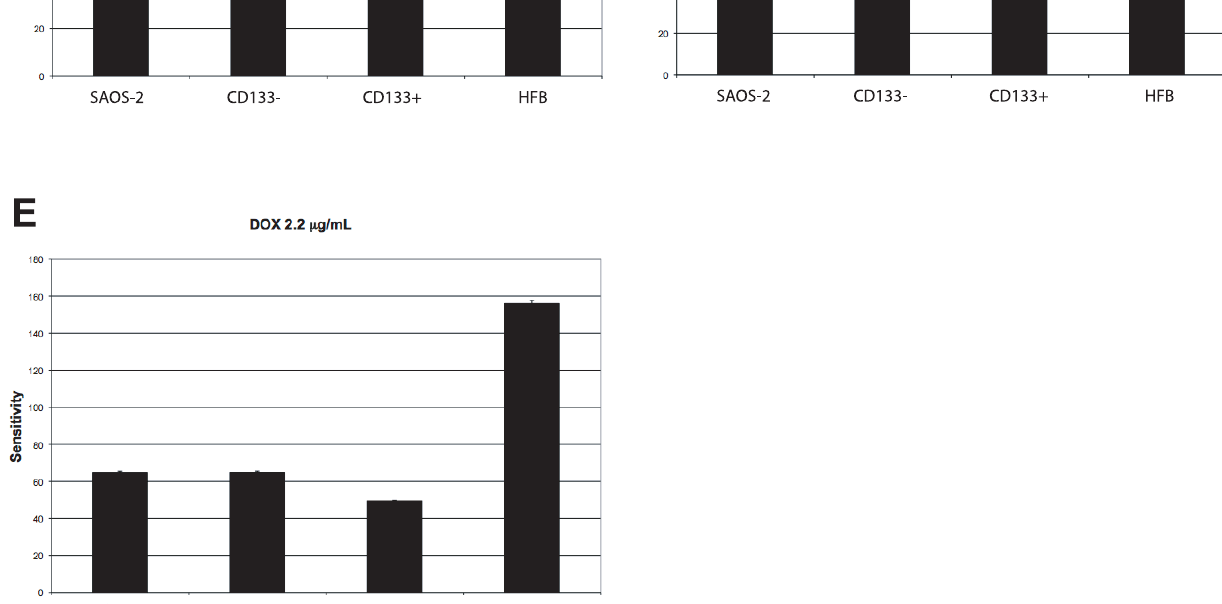
Figure 9. Sensitivity of SAOS-2 cells to doxorubicin following growth in simulated hypogravity. A ) LD 50 for doxorubicin determined for the SAOS-2 cells. An LD 50 of 0.5 m g/mL for doxorubicin was determined exposing the SAOS-2 cells to a 24-hours treatment to the drug, using an MTT assay. Comparable results were obtained with cell count by trypan blue exclusion. B ) Histogram showing the sensitivity of SAOS-2 cells to 0.25 m g/mL of doxorubicin following a 24-hours treatment, and using an MTT assay. CD133( + ) cells are sensitive to the chemotherapy treatment, but the CD133( + ) SAOS-2 cells proliferated and selected with the HFB culture system are even more sensitive to the treatment, instead. C ) Histogram showing the sensitivity of SAOS-2 cells to 0.5 m g/mL of doxorubicin following a 24-hours treatment, using an MTT assay. CD133( + ) cells show sensitivity to the clinically relevant dose of 0.5 m g/mL of doxorubicin, however the CD133( + ) SAOS-2 cells proliferated and selected with the HFB culture system are greatly sensitized to the chemotherapy treatment. D ) Histogram showing the sensitivity of SAOS-2 cells to a dose of 1.1 m g/mL of doxorubicin following a 24-hours treatment, and using an MTT assay. The CD133( + ) cells show sensitivity to a dose of 1.1 m g/mL of doxorubicin, however the CD133( + ) SAOS-2 cells proliferated and selected with the HFB culture system are sensitized to the chemotherapy treatment. E ) Histogram showing the